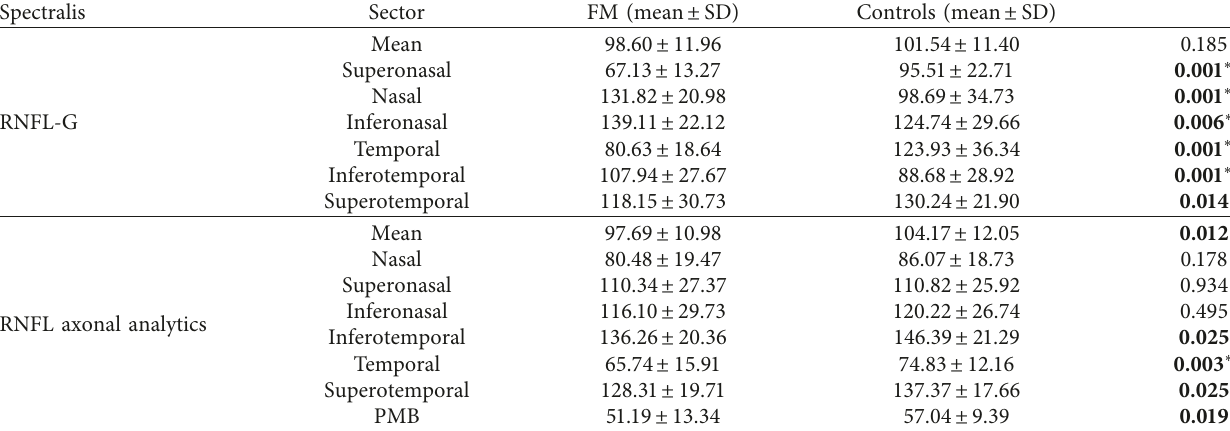
Table 4: Peripapillary measurements (in microns) of the retinal nerve fiber layer in patients with fibromyalgia and healthy controls using the two different protocols for spectralis OCT—the RNFL-G protocol and the RNFL-Axonal analytics protocol. Bold numbers indicate p < 0 . 05, asterisks indicate significant values according to the Bonferroni’s correction for multiple comparisons ( p < 0 . 007). Spectralis